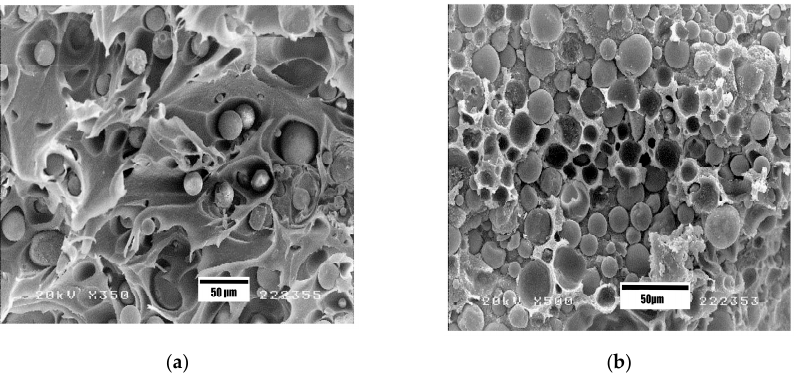
Figure 10. SEM fractographs of ( a ) PEEK-10 vol% mHA and ( b ) PEEK-40 vol% mHA microcomposites, showing debonding of mHA particles from the PEEK matrix. Reproduced from [131] with permission of Elsevier.